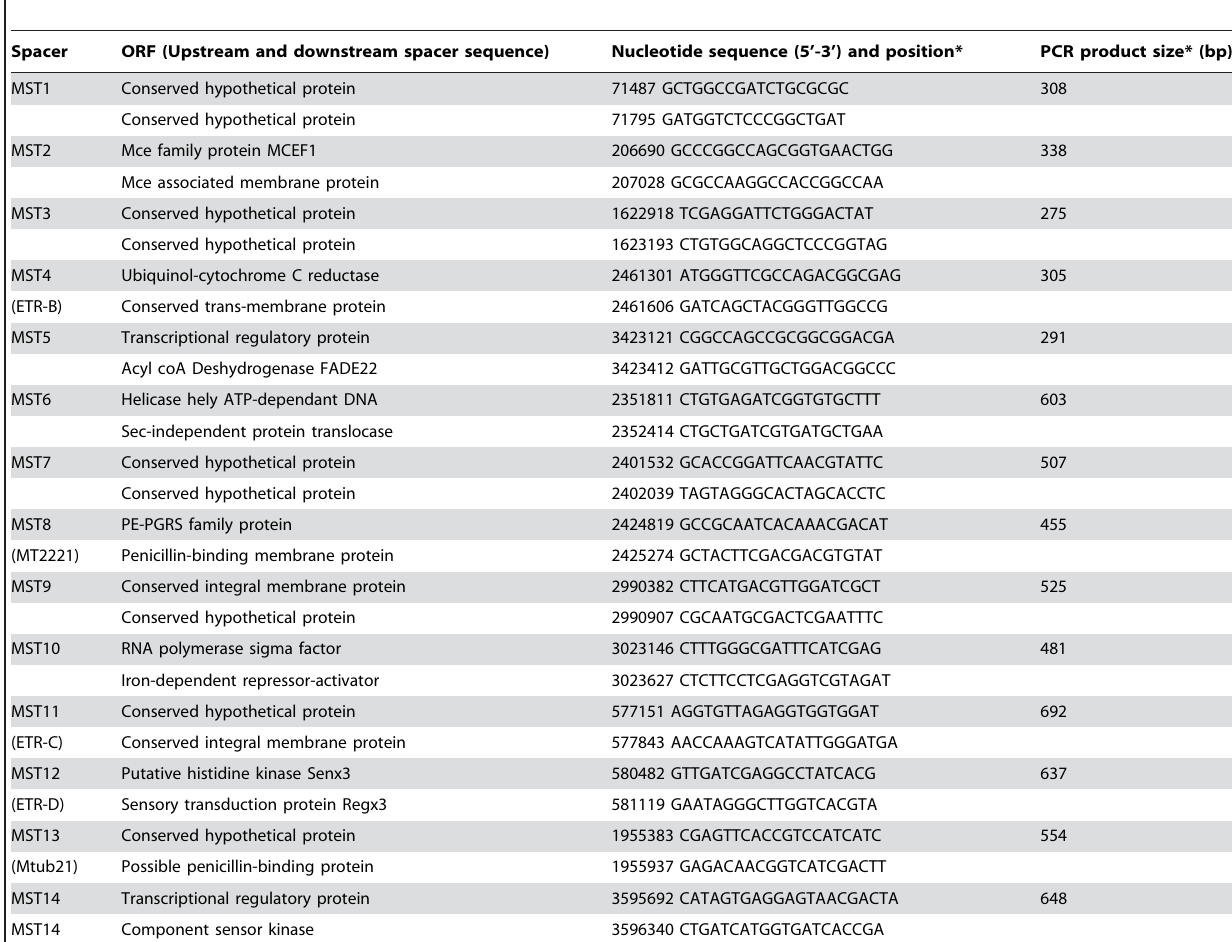
Table 1. Primers used for PCR amplification and sequencing of M. tuberculosis